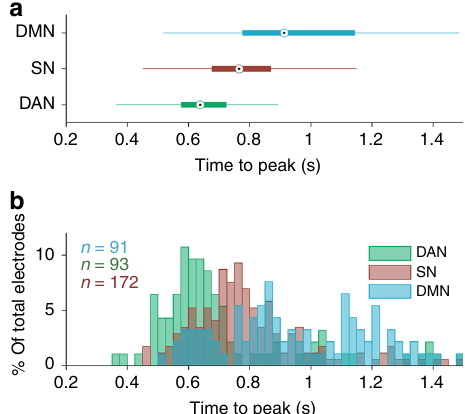
Fig. 3 Time-to-peak (TTP) of task-evoked HFB responses varies among networks. a Box plots showing TTP for all task-responsive electrodes within each network (based on HFB increase for DAN and SN and HFB decrease for DMN). The central point indicates median, box bounds indicate 25th and 75th percentiles, and whiskers indicate most extreme data points not considered to be outliers. b Histogram of the distribution of TTP values for all